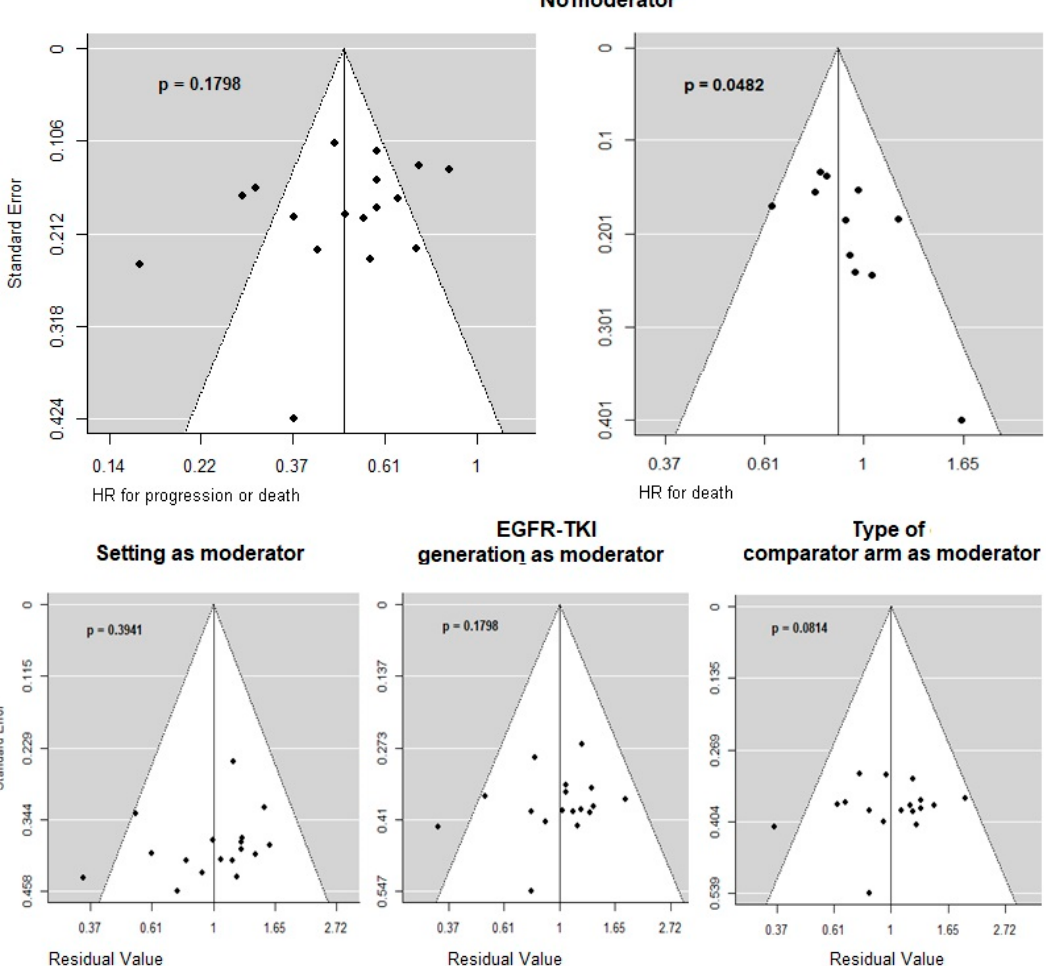
Figure 2. Funnel plots for OS- and PFS-HR. Reporting bias was assessed by visually evaluating asymmetry and by statistical test, for which p -values are reported. The y-axis reports standard error in all graphs. Above, the x-axis reports the effect sizes (HR for progression or death on the left and the HR for death on the right). Below, the x-axis reports the residual values instead of effect sizes considering setting, EGFR-TKI generation, and type of comparator arm as moderator variables.